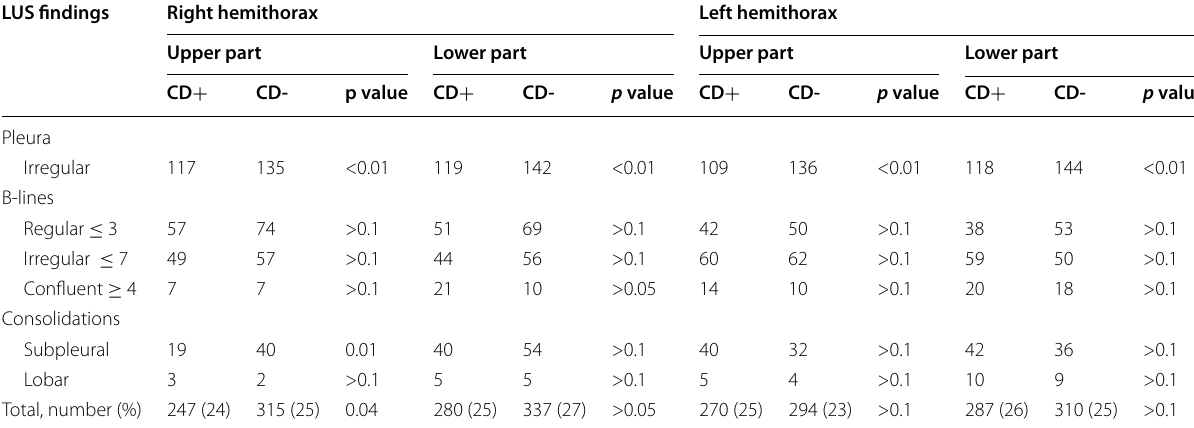
Each hemithorax was divided into upper and lower parts, including LUS findings of one anterior and one lateral region per part. According to their cardiac dysfunction (CD and CD ), findings were presented after patients division in two + −